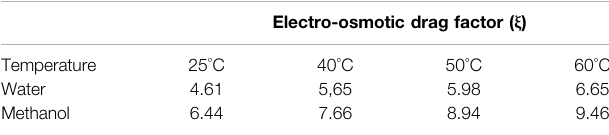
TABLE 1 | Electro-osmotic drag factor, ξ , for pure water and methanol in Na fi on 117 at several